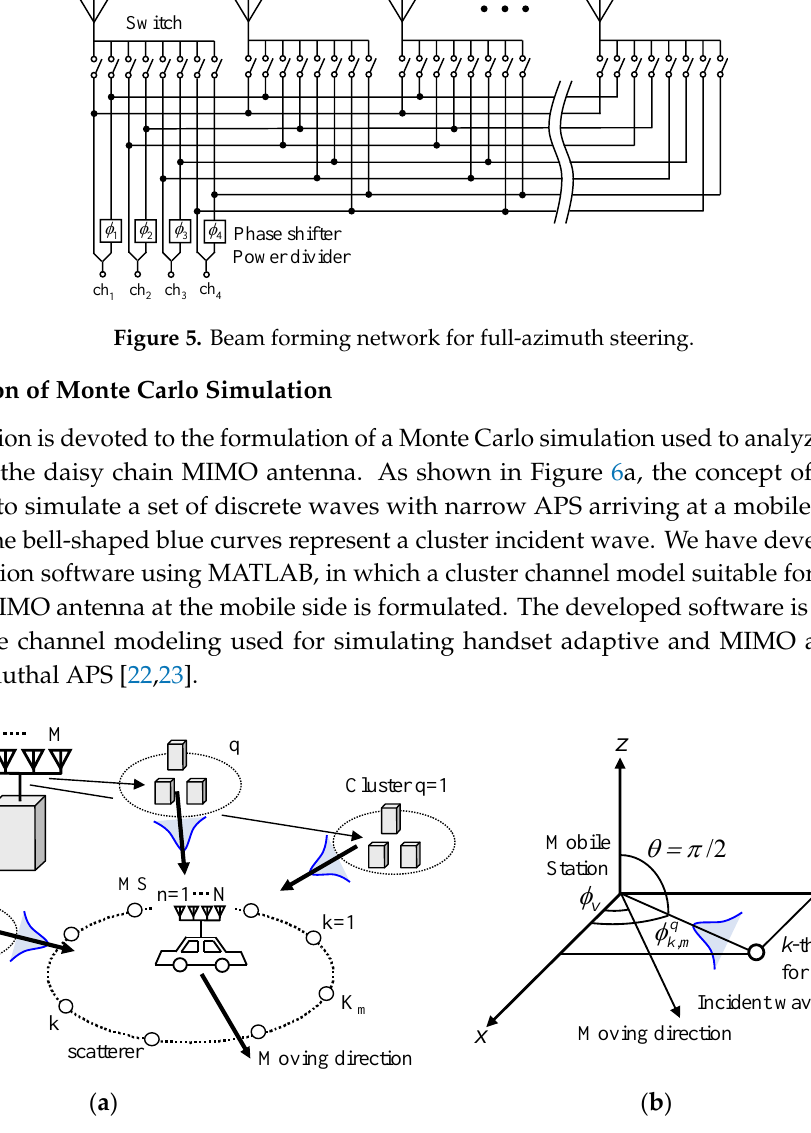
Figure 6. Channel model used for performing the Monte Carlo simulation. ( a ) Cluster channel model of M × N MIMO. ( b ) Coordinates of the k -th scatterer.